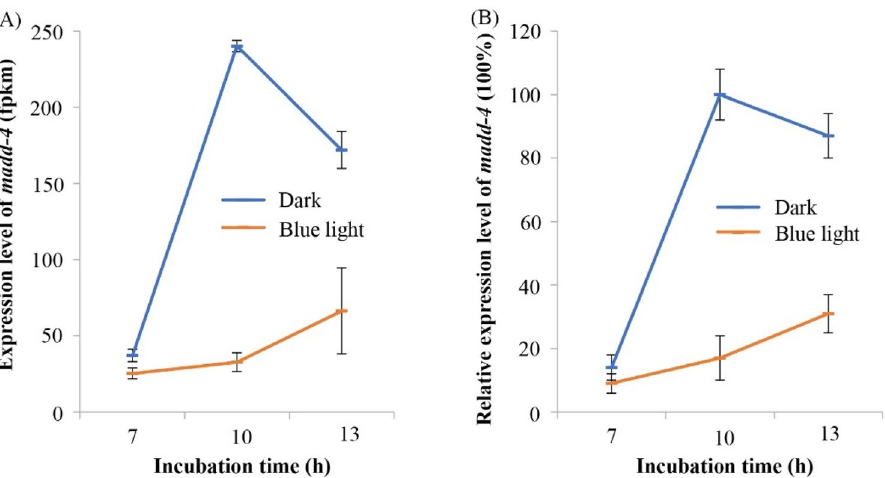
Figure 3. The expression levels of Bxy-madd-4 during embryogenesis in B. xylophilus . Synchronized eggs were incubated under blue light-emitting diode (462 ± 6 nm; 1200 lx) and dark conditions at 25 °C, for 7, 10, and 13 h, respectively. ( A ) All FPKM values of Bxy-madd-4 obtaining from RNA-Seq results. Each sample has three biological replicates. ( B ) The relative expression level of Bxy-madd-4 was determined by RT-qPCR, normalized with β-actin and tbb-2 as the reference genes. The expression level of 10 h in dark conditions was appointed as 100%. RT-qPCR reactions were performed in triplicate. Error bars represent the standard error of the